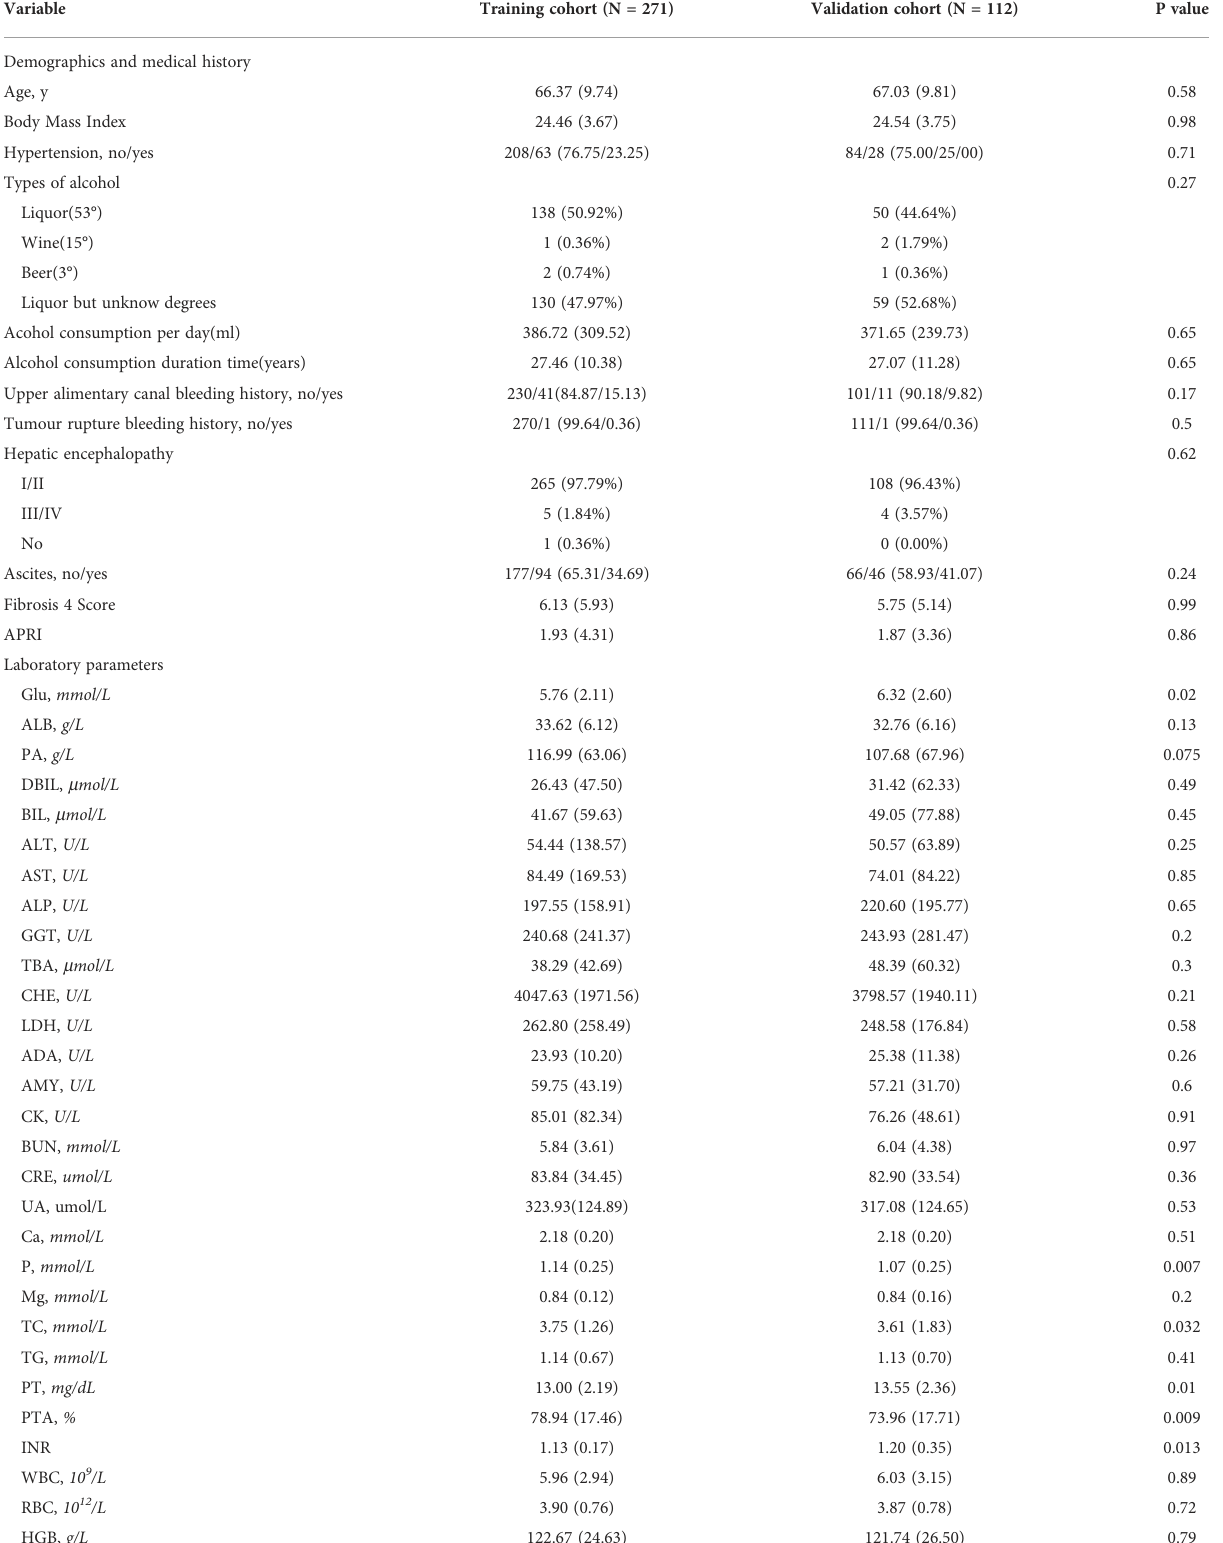
TABLE 1 Baseline characteristics of training and validation cohorts after deleting unknown/missing